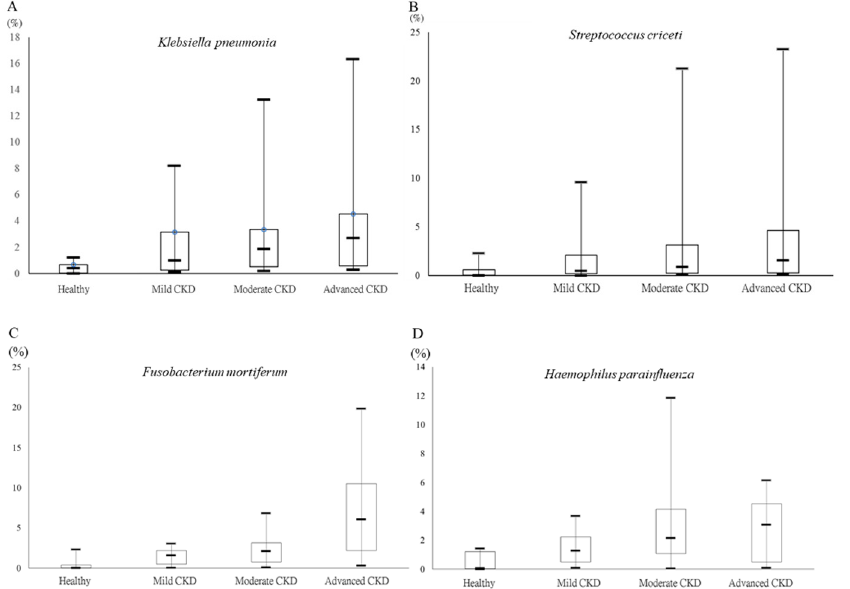
Figure 5. Differential abundances of identified taxa between healthy participants and chronic kidney disease (CKD) patients cross distinct stages. Relative abundances of ( A ) Klebsiella pneumonia , ( B ) Streptococcus criceti , ( C ) Haemophilus parainfluenzae , and ( D ) Fusobacterium mortiferum in the fecal samples of all groups are shown in a box